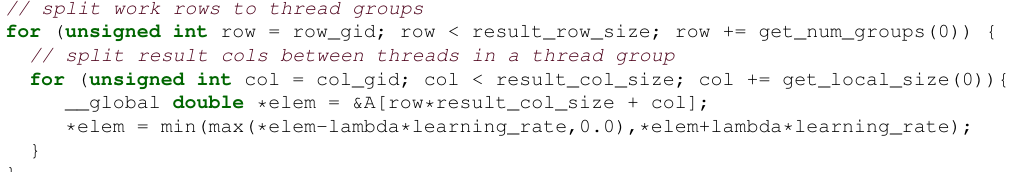
Figure 4. OpenCL kernel for the proximal operator, where the matrix A contains w k − η G ( w k )